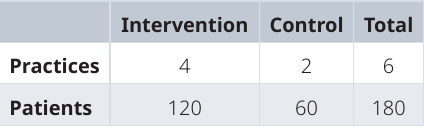
Table 2. Patient recruitment target in control and intervention